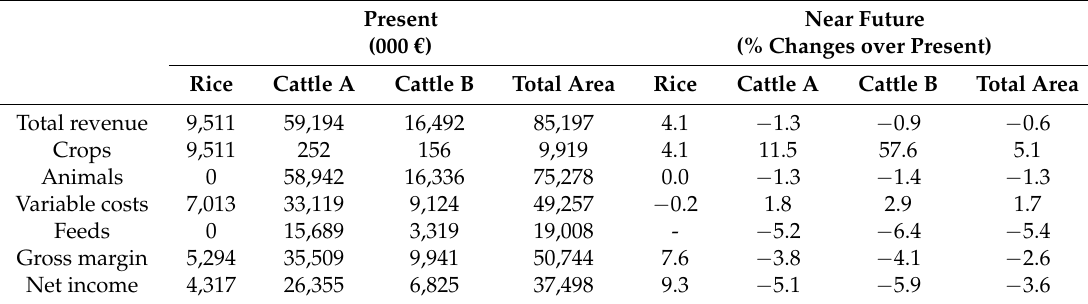
Table 2. Economic results for the baseline and near-future scenario, absolute values (000 € ), and percentage changes [47].